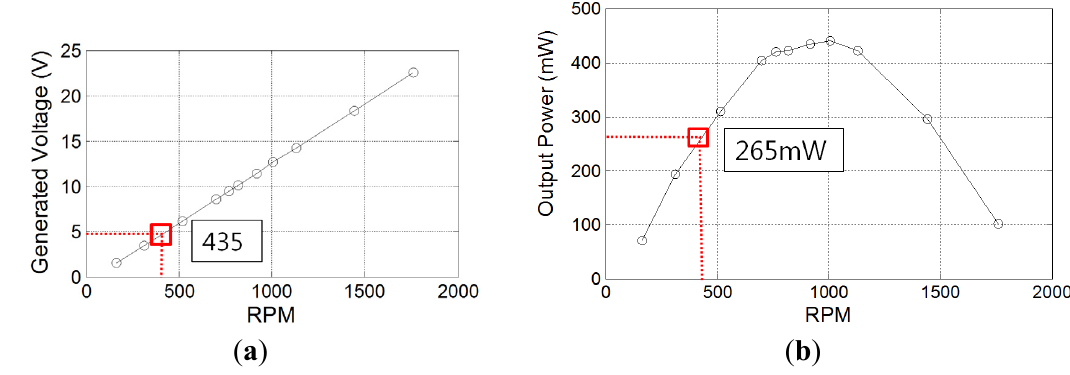
Figure 13. Output power and output voltage (at 7 m/s): ( a ) RPM versus the output voltage; ( b ) RPM versus the output